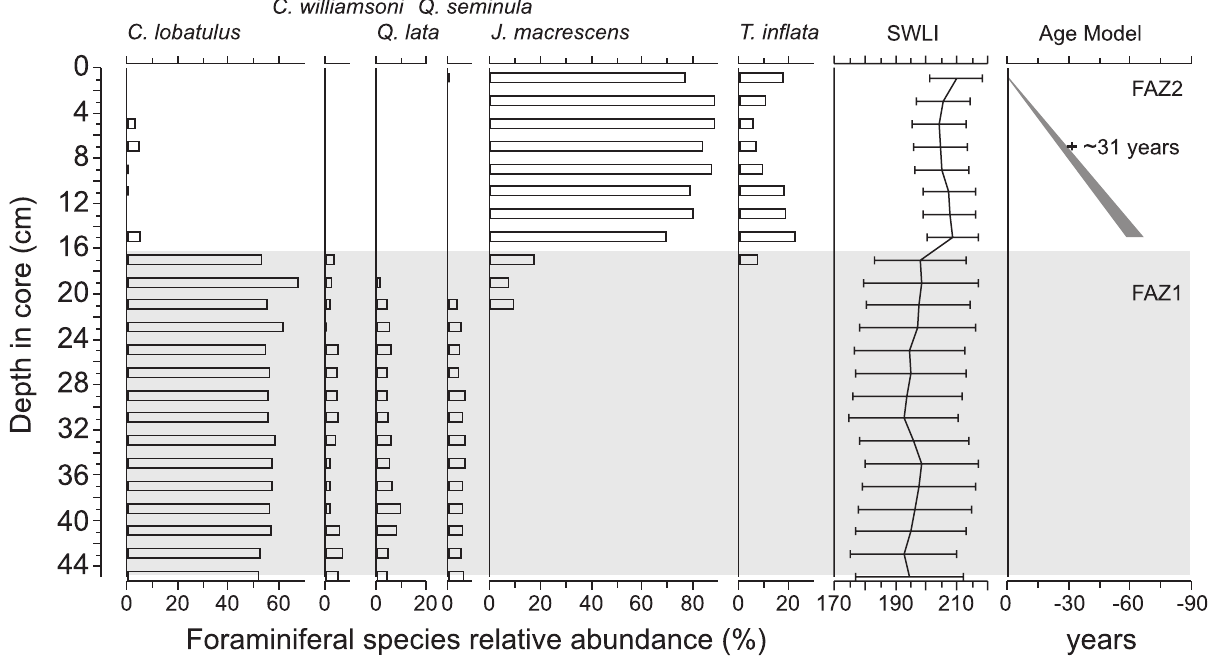
Fig . 2. – relative abundance of main foraminiferal species, predicted palaeoelevation produced by the transfer function and sedimentation rates-derived age (table 3) with depth (cm) referred to standardised water level index (SWLi). age model chronology is represented as 2 σ error (dark grey area). Cross indicates heavy metal concentration–derived age. FaZ, Foraminiferal assemblage